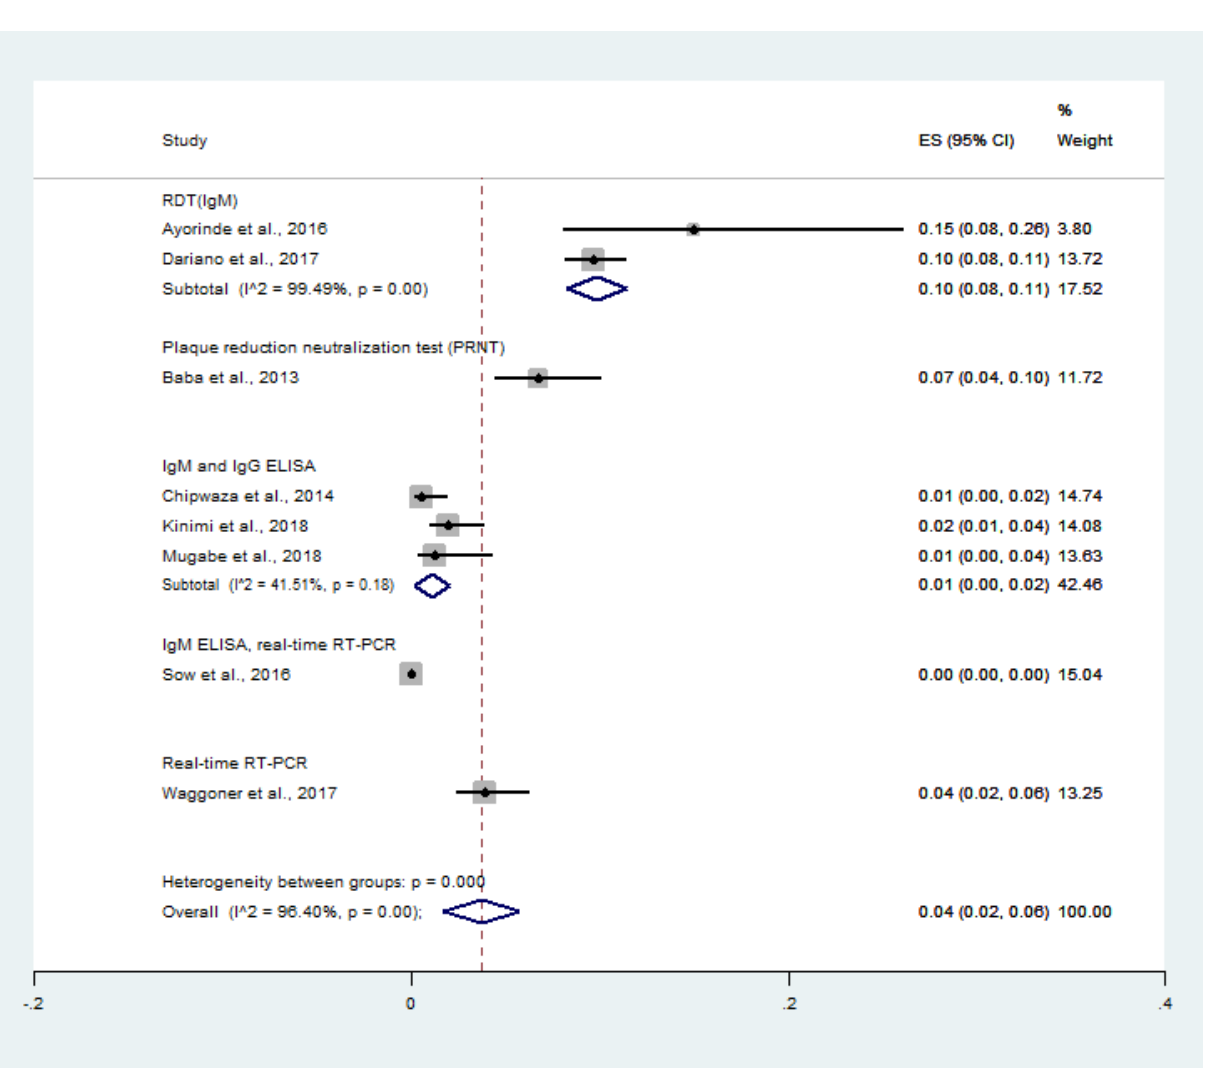
Figure 3. Prevalence of malaria and CHIKV co-infection among febrile patients using diagnostic tests: % weighted, the impact proportion of each study to the pooled effect; the black dot symbol on the black horizontal line, the point estimate for each study; the black horizontal line, CI; the white diamond symbol, the pooled prevalence; CI, confidence interval; ES, effect size (prevalence).